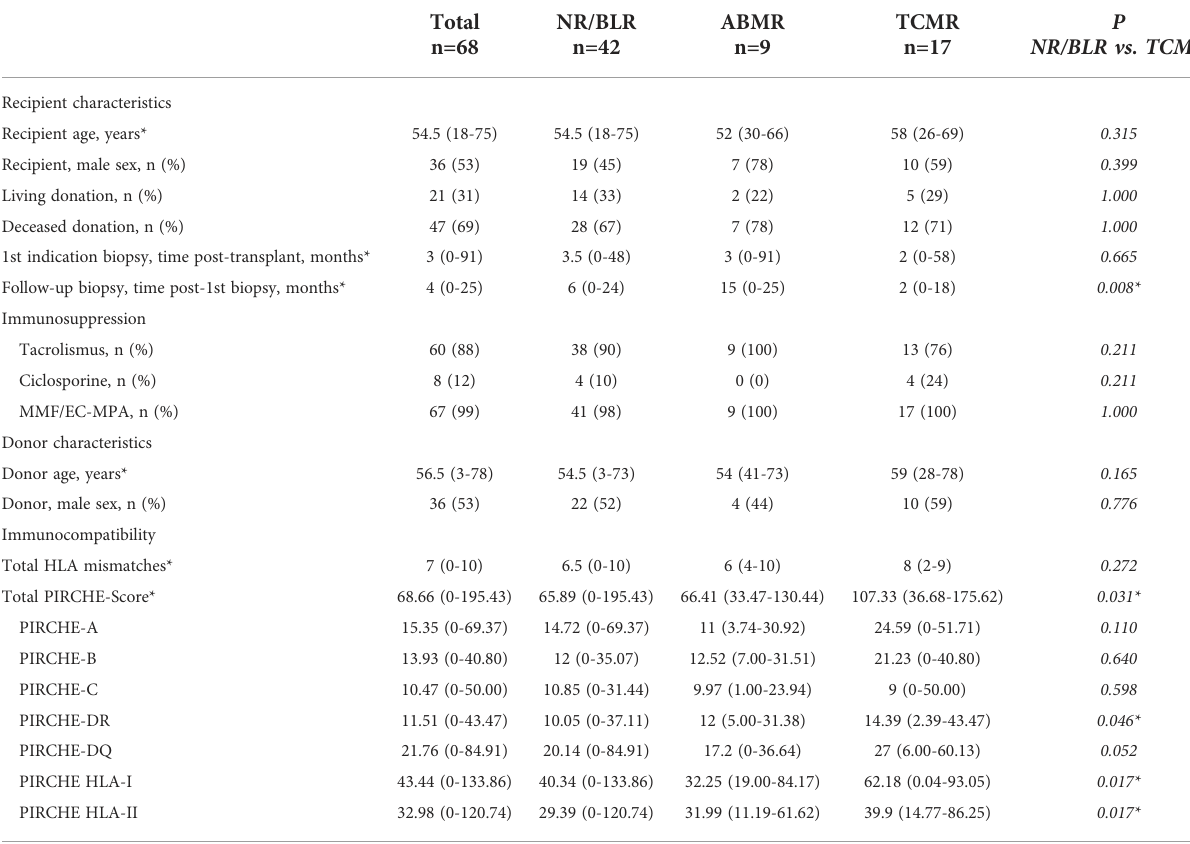
TABLE 1 Basic characteristics of 68 KTRs with NR/BLR in the fi rst indication biopsy and grouping based on the results of the follow-up